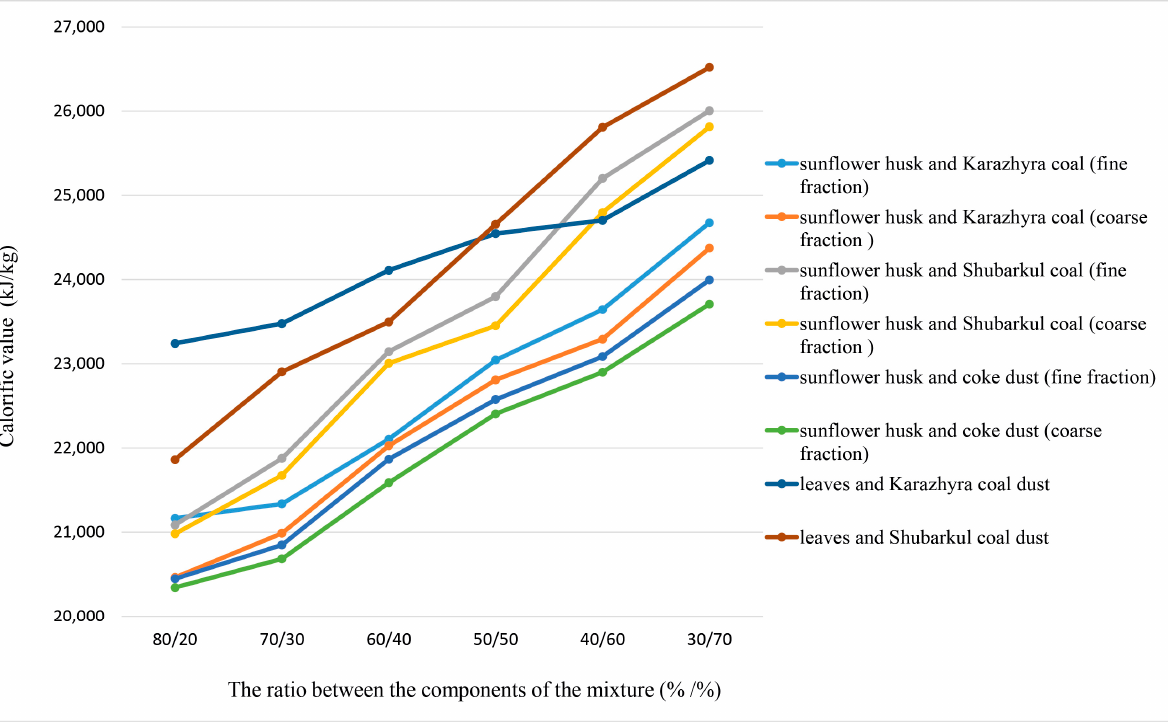
Figure 4. Change in the calorific value of briquettes depending on the type and ratio of the compo- nents of the mixture.